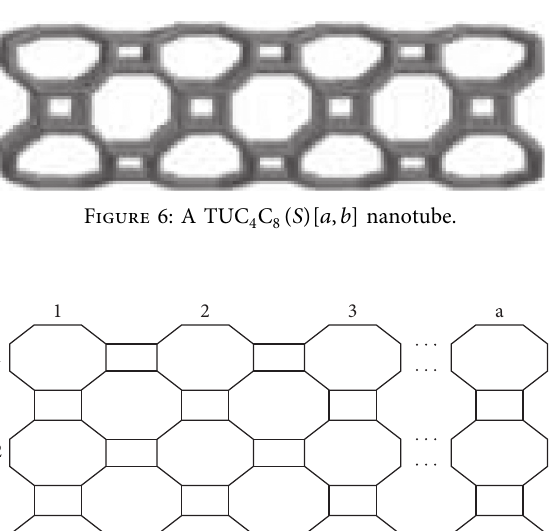
( S ) nanosheet T 1 [ a,b ] C 4 8